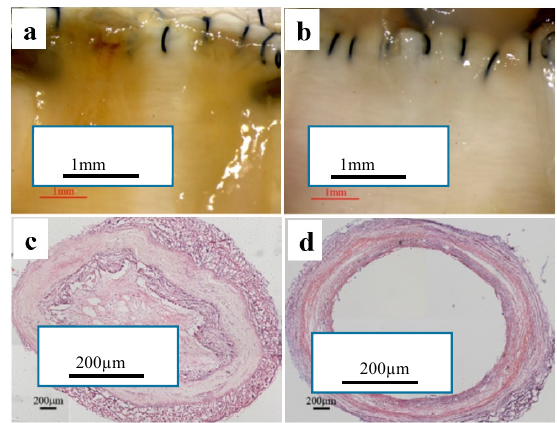
Figure 11. Investigation of explanted ( a ) PCL graft and ( b ) PCL-arginine-glycine-aspartic acid (RGD) graft by stereomicroscope and ( c , d ) cross-section staining after four weeks of implantation.